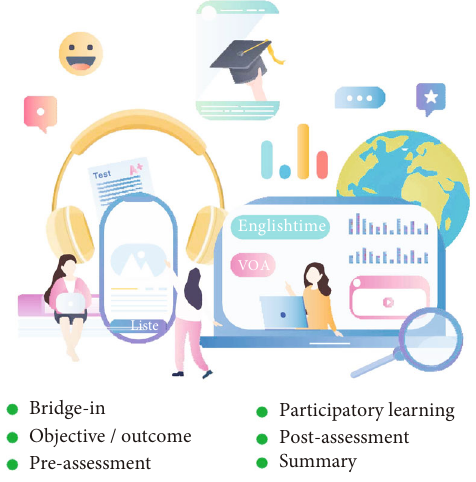
Figure 2: Structure of BOPPPS teaching